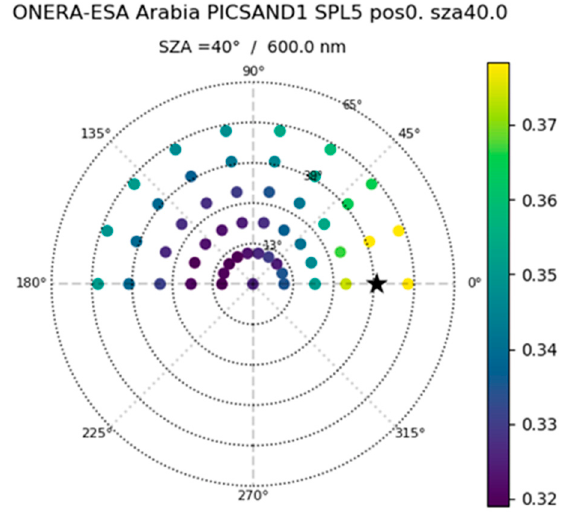
Figure 19. Polar diagram of the BCRF measured with BBGE for the Arabia_PICSAND1_SPL5 sand sample (position at 0°) and for an illumination angle (SZA) of 40°.